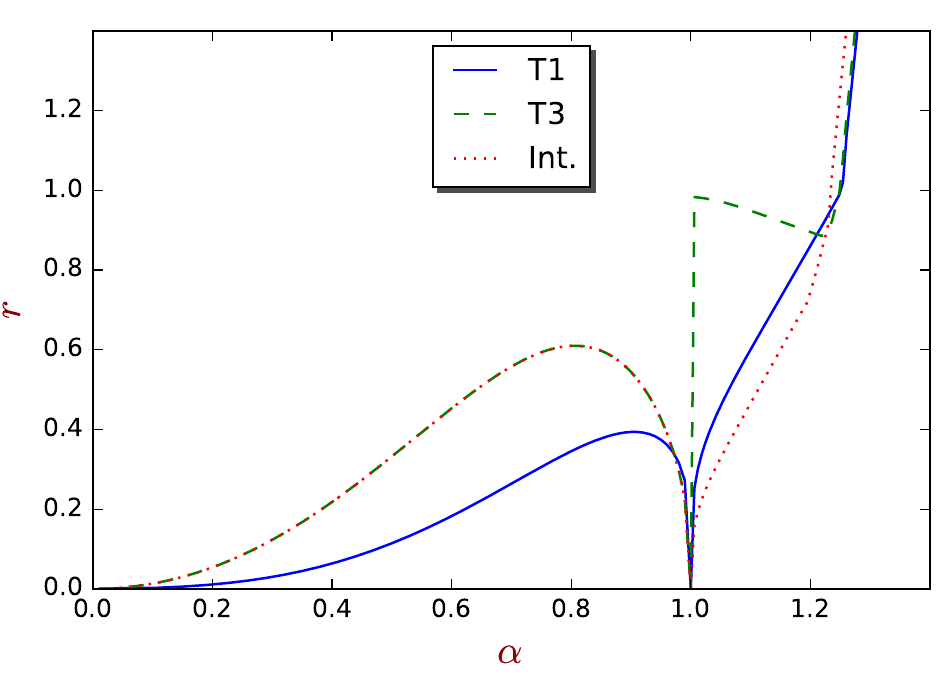
Fig. 5 Spectral radius of the AM5 methods for T1, T3 and interpolation